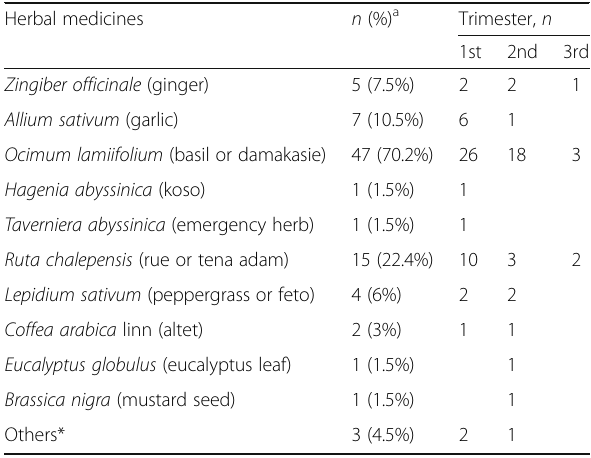
Table 6 Herbal medicines used for self-medication by the pregnant women by trimester, Addis Ababa, 2017 ( n = 67) Herbal